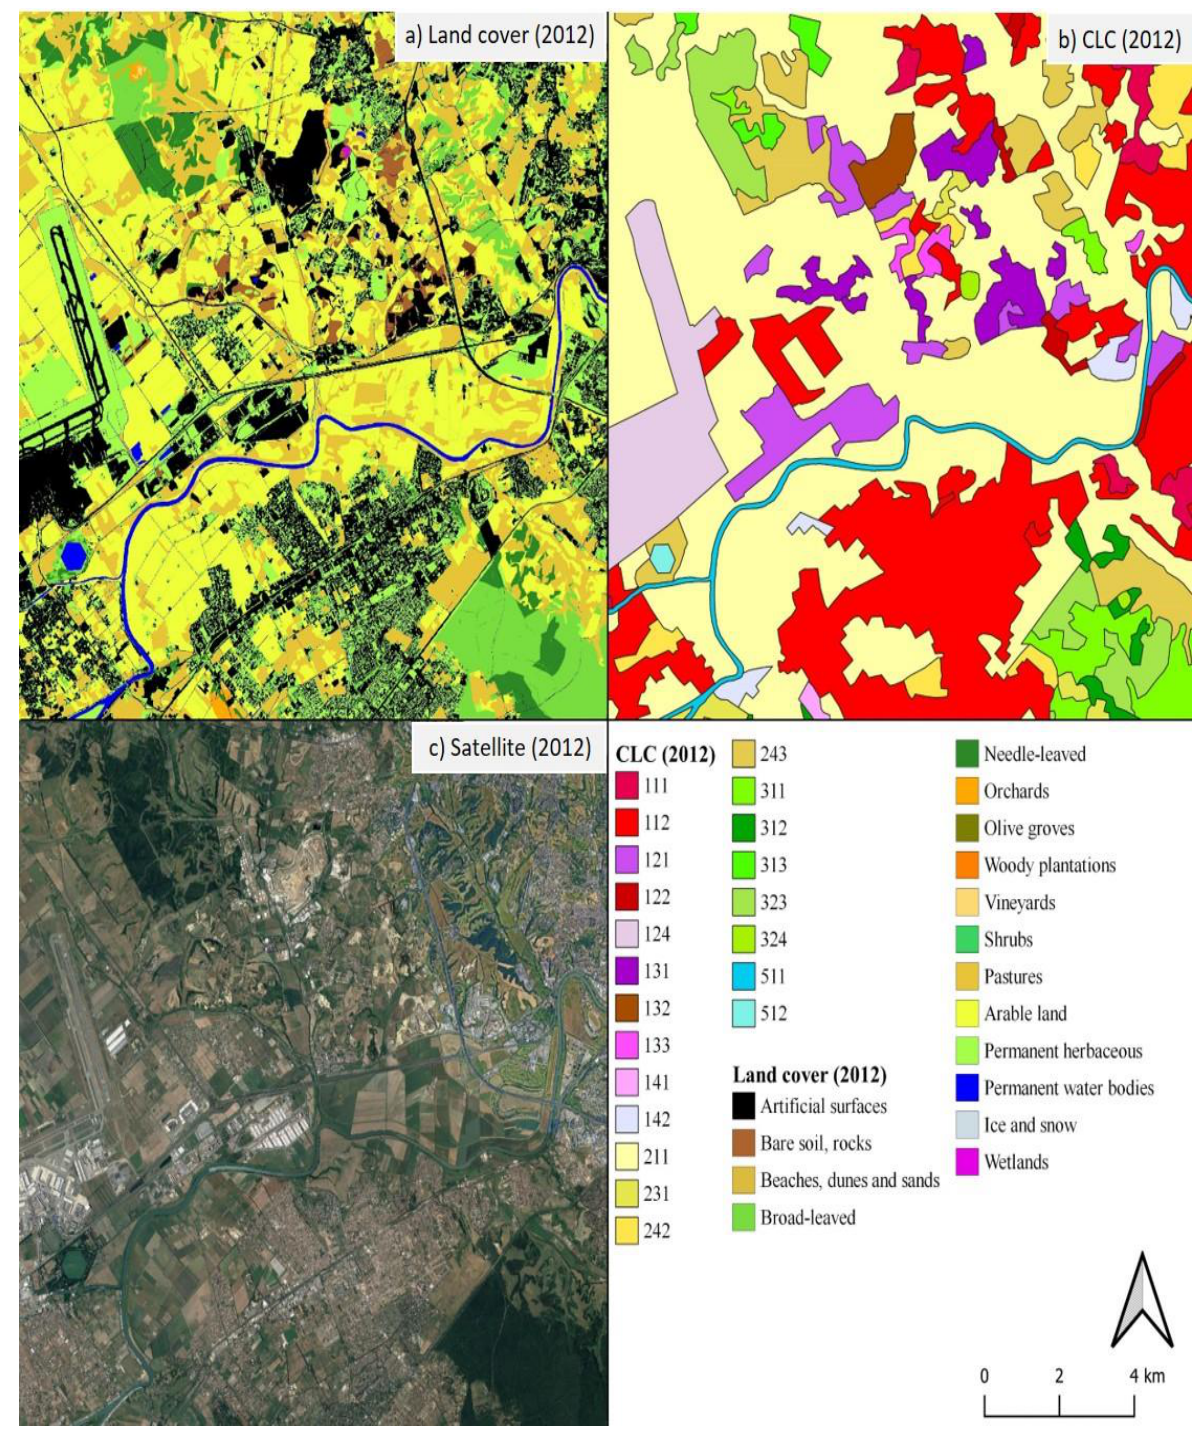
Figure 6. Comparison between land cover map for 2012 ( a ), CORINE Land Cover ( b ) and satellite image ( c ), focusing on urban area.